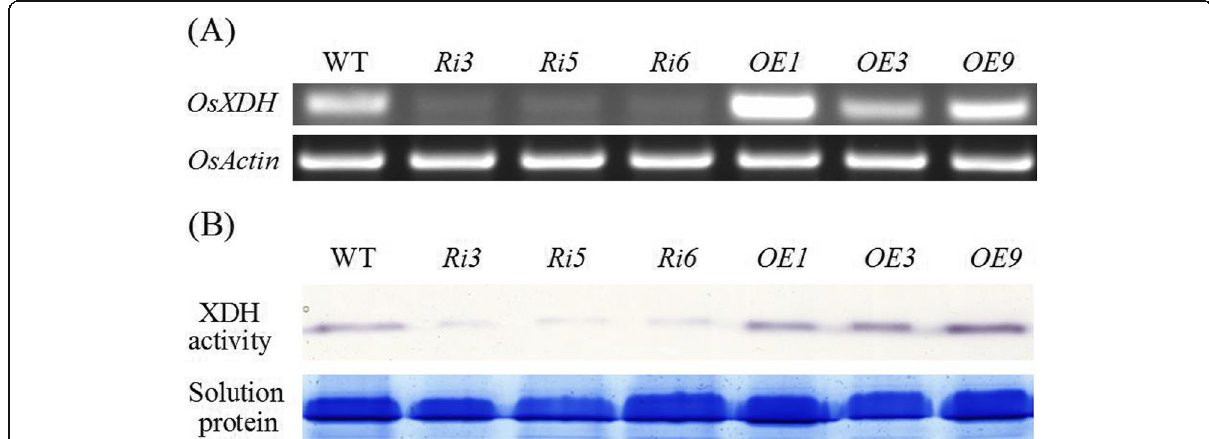
Fig. 2 The relative expression level of OsXDH and XDH activity in wild-type and transgenic plants. a Expression analysis of OsXDH in rice seedlings cultured for 30 days . Ri3 , Ri5, and Ri6 were XDH interference transgenic lines, and OE1, OE3, and OE9 were XDH over-expression transgenic lines . The internal reference gene was OsActin . b Enzyme activity analysis of XDH in rice seedlings cultured for 30 days. Soluble protein was extracted from rice seedling leaves grown for 30 days. Each lane in the gel was loaded with equal content soluble protein. XDH activity was detected in gel